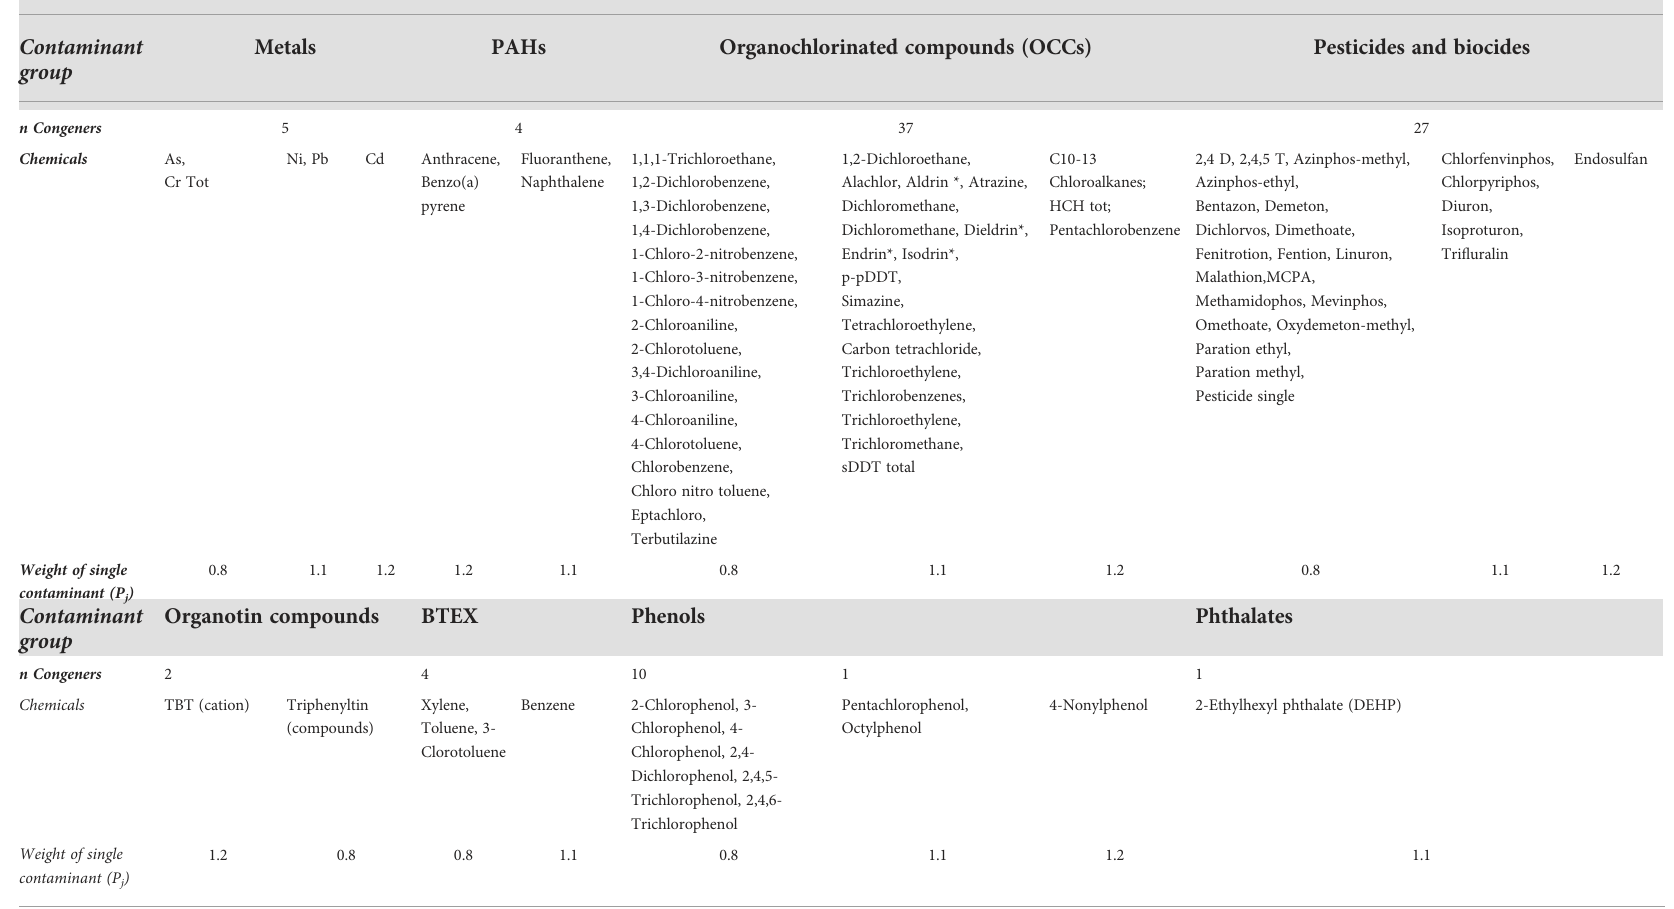
TABLE 1 Contaminants monitored in water and weight of single